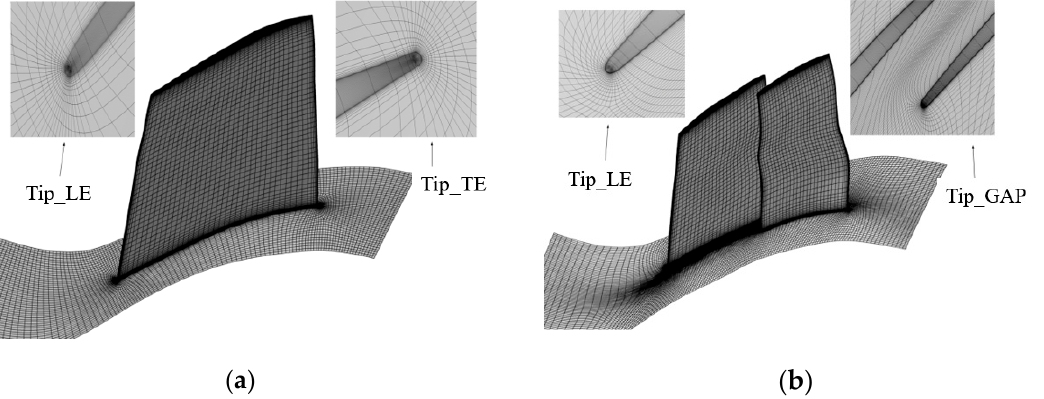
Figure 3. The final computational grid of rotor37 and the original tandem rotor. ( a ) rotor37. ( b ) the original tandem rotor.